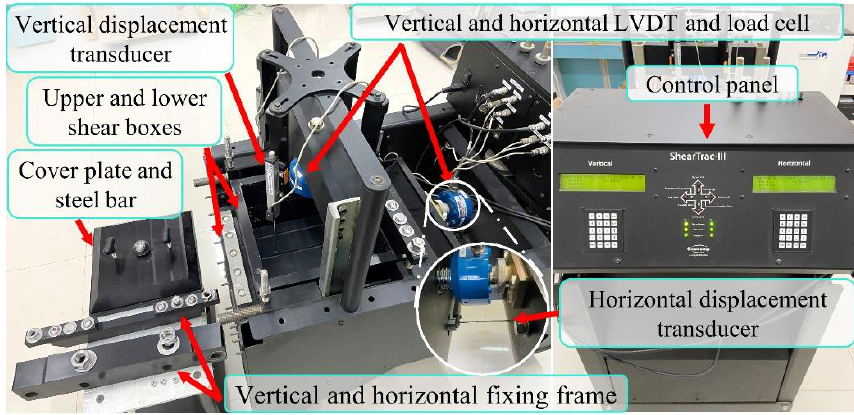
Figure 1. Large-scale direct shear system (Shear Trac Ⅲ ).